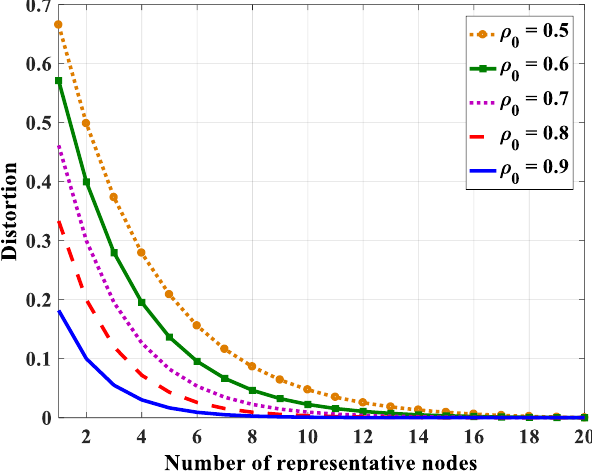
Figure 19. The relation between distortion and the number of representative nodes in the case N = 15. Sensors 2018 , 18 , x FOR PEER REVIEW 27 of 35